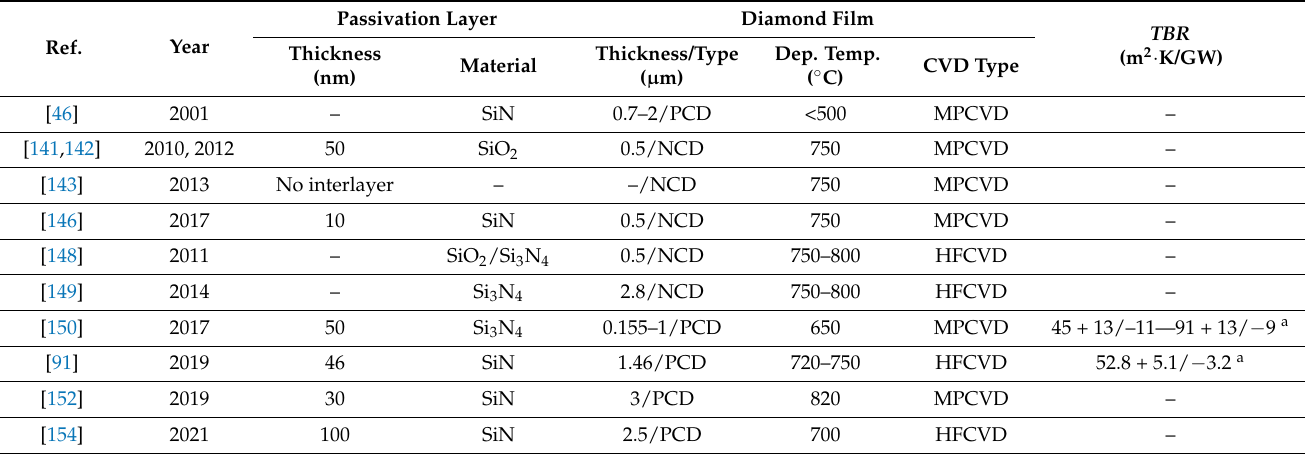
Table 6. Evolution of capping diamond